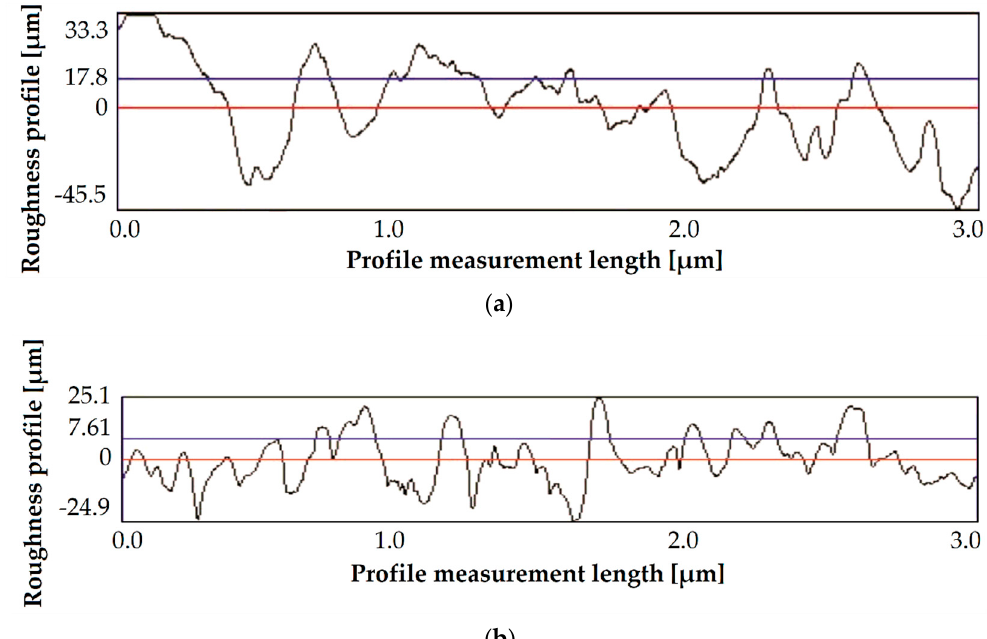
Figure 7. Surface topology of the samples (atomic force microscopy): ( a ) after production; ( b ) after cavitation-abrasive finishing.